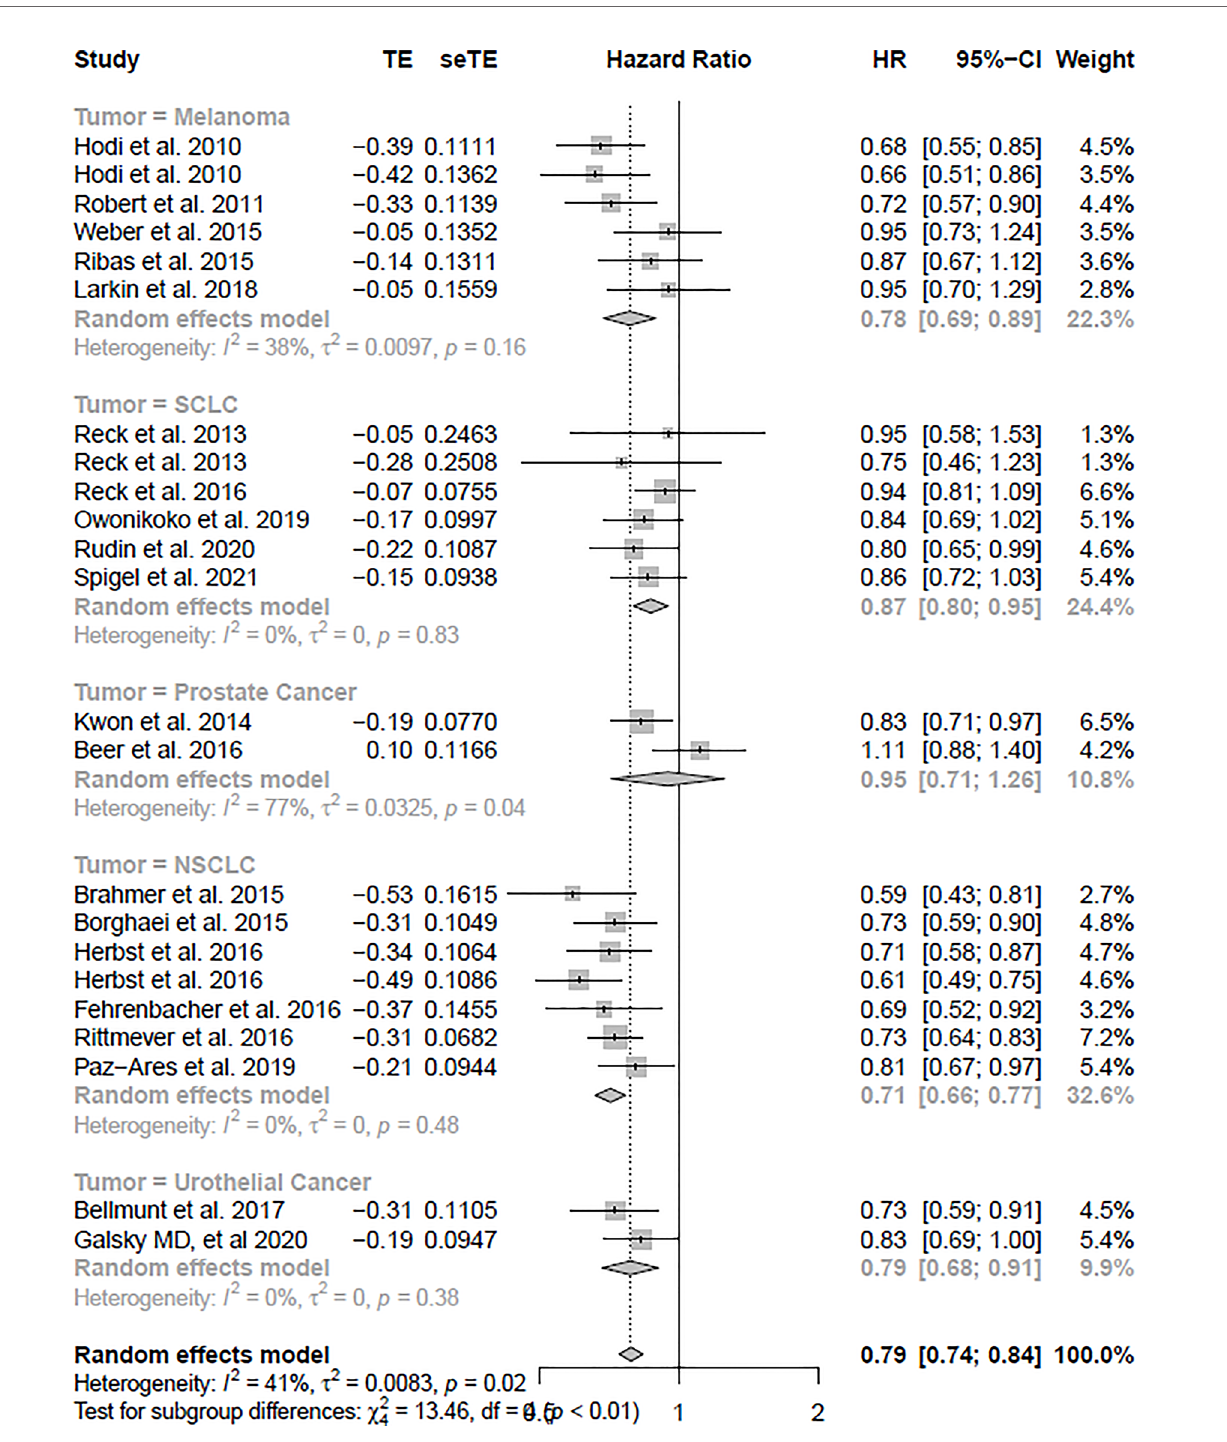
FIGURE 3 | The forest plot of OS in the random-effect